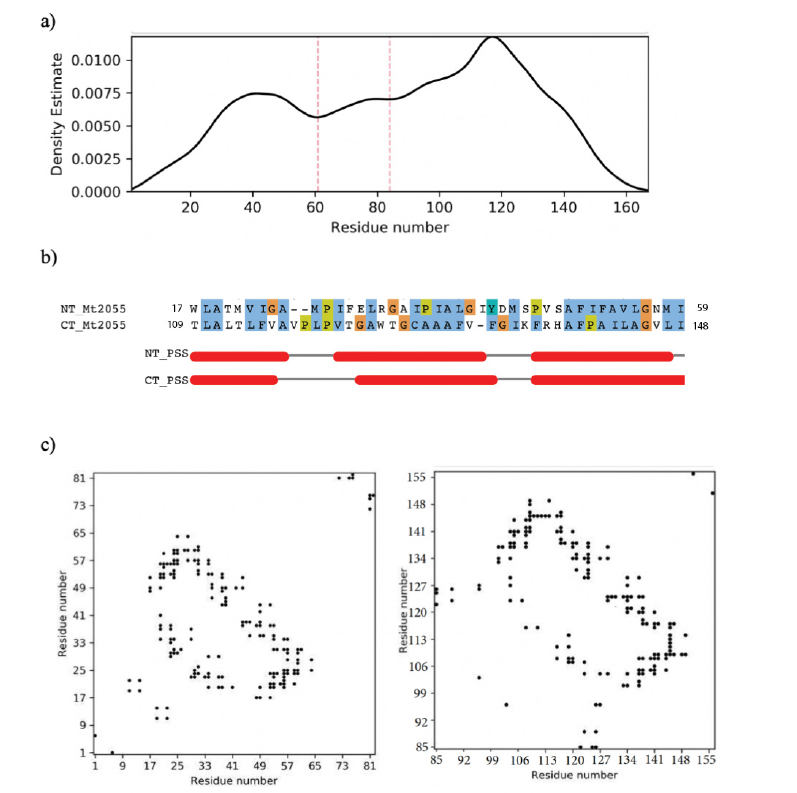
Figure 2. Mt2055 domain analysis. ( a ) Contact density profile constructed by ConKit (Simkovic et al ., 2017b) utilising DeepMetaPSICOV contact prediction. Solid black line represents contact density and dotted red lines mark density minima corresponding to possible domain boundaries. ( b ) HHalign alignments for the N-terminal and C-terminal Mt2055 halves, formatted using Jalview (Waterhouse et al ., 2009) and coloured according to the ClustalX scheme. Red bars represent helical secondary structure. ( c ) Maps of predicted contacts generated by DeepMetaPSICOV and plotted using ConKit; left is N-terminal half (residues 1-84) and right is C-terminal half (residues 85-168). Black points represent predicted intramolecular